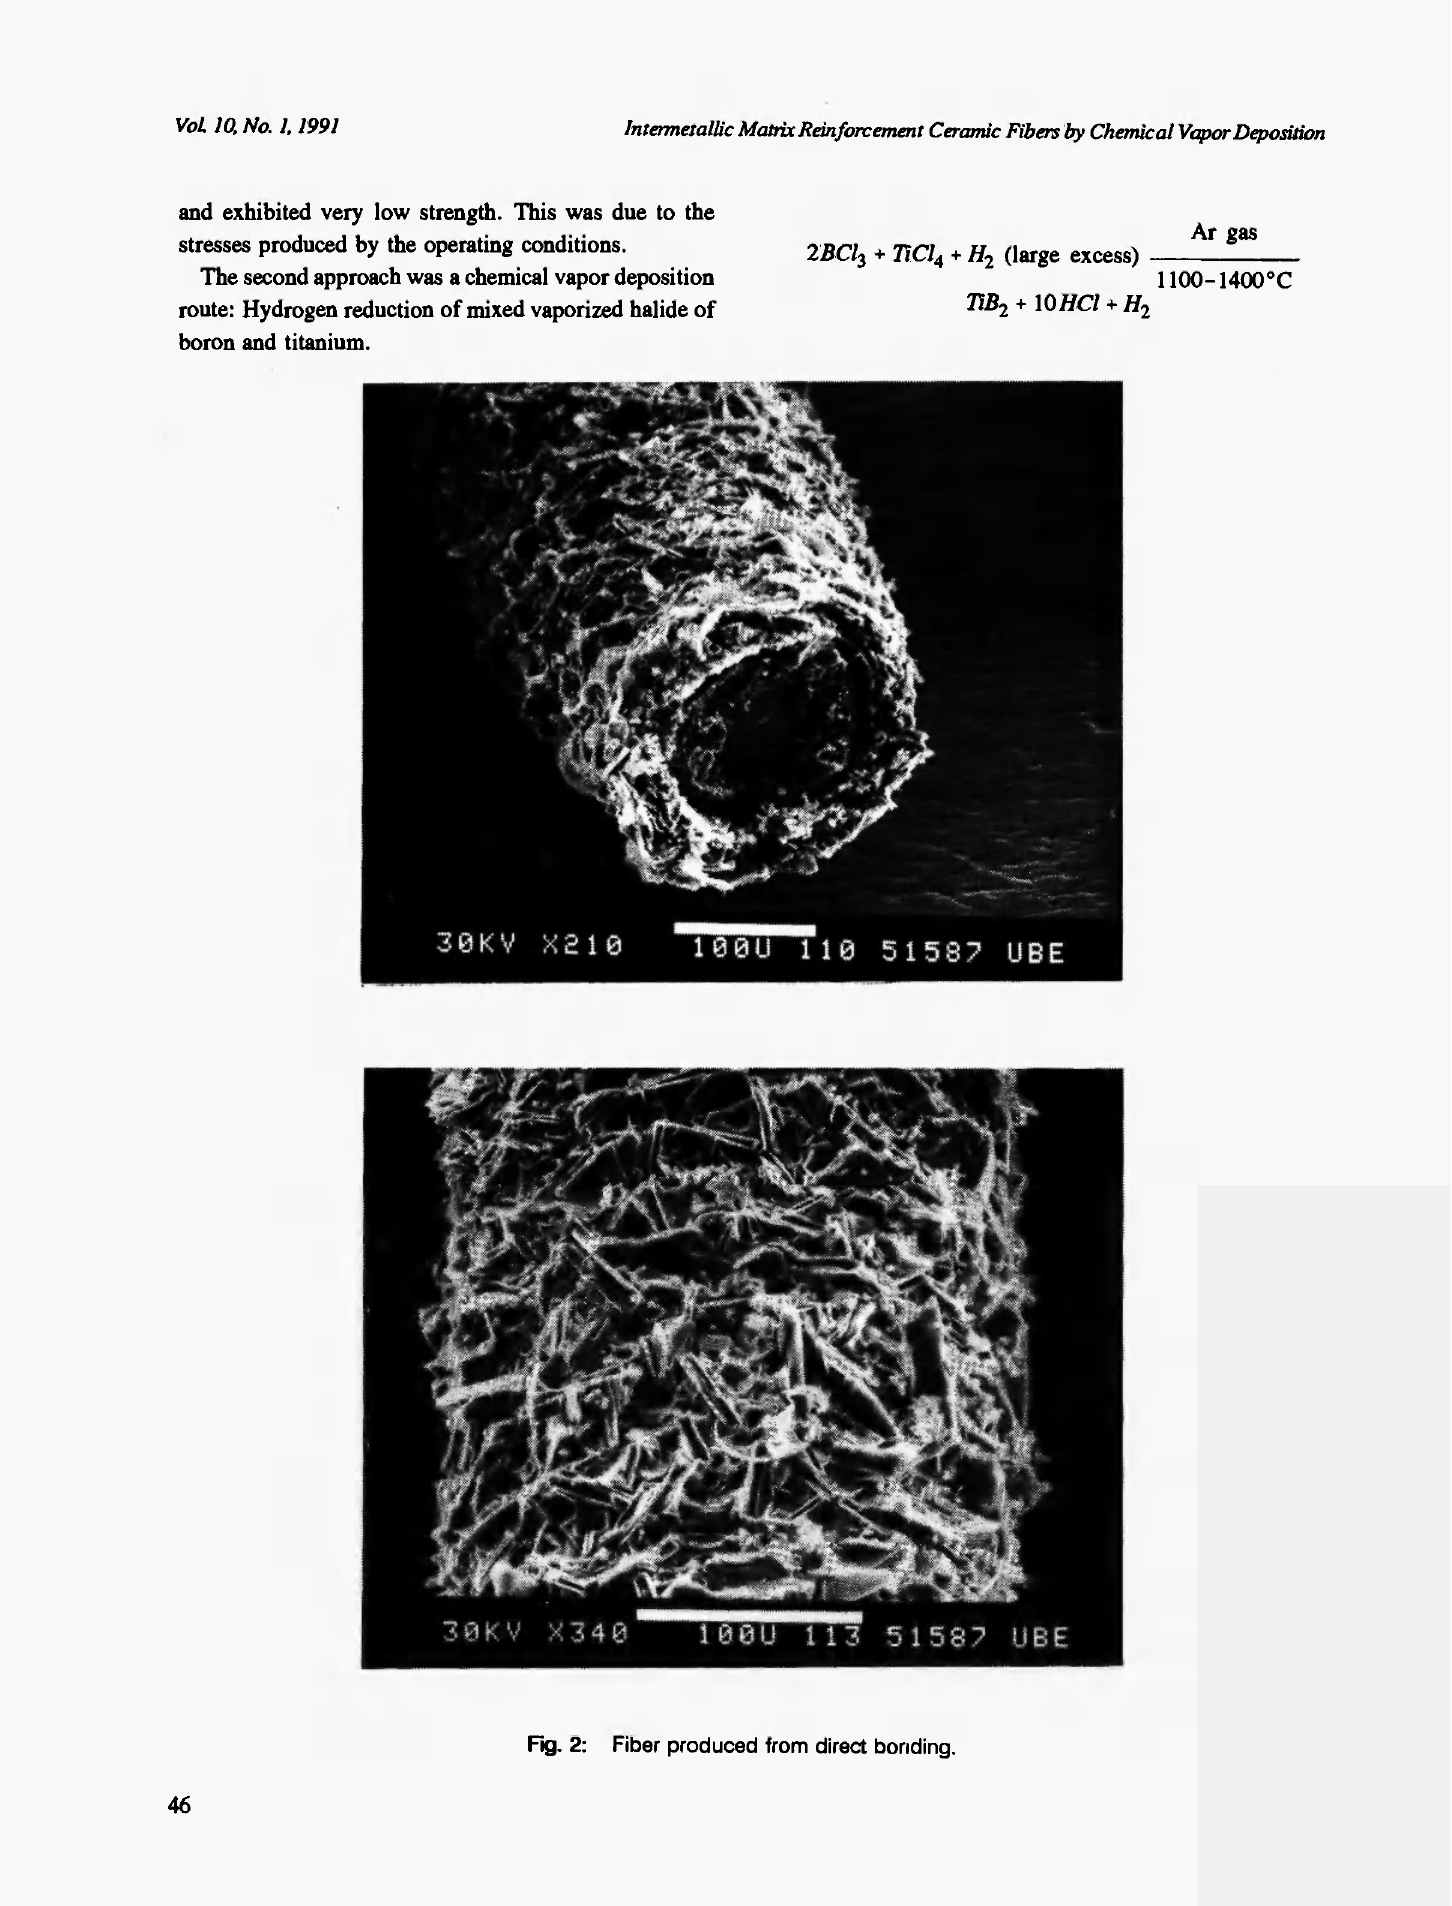
Fig. 2: Fiber produced from direct